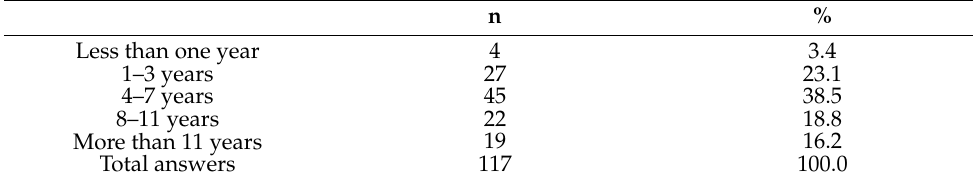
Table 2. Time of cohabitation.